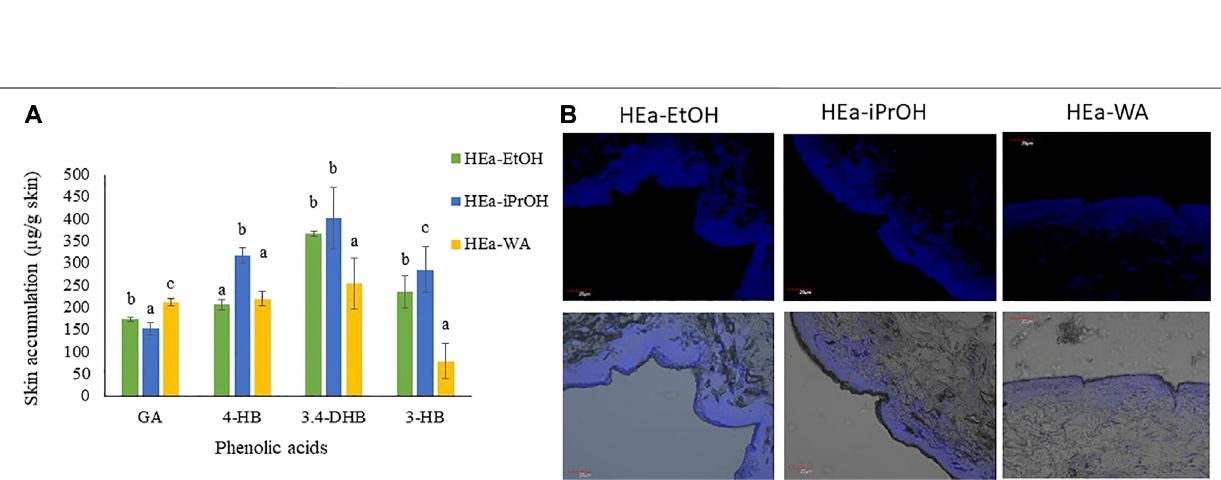
Frontiers in Pharmacology |